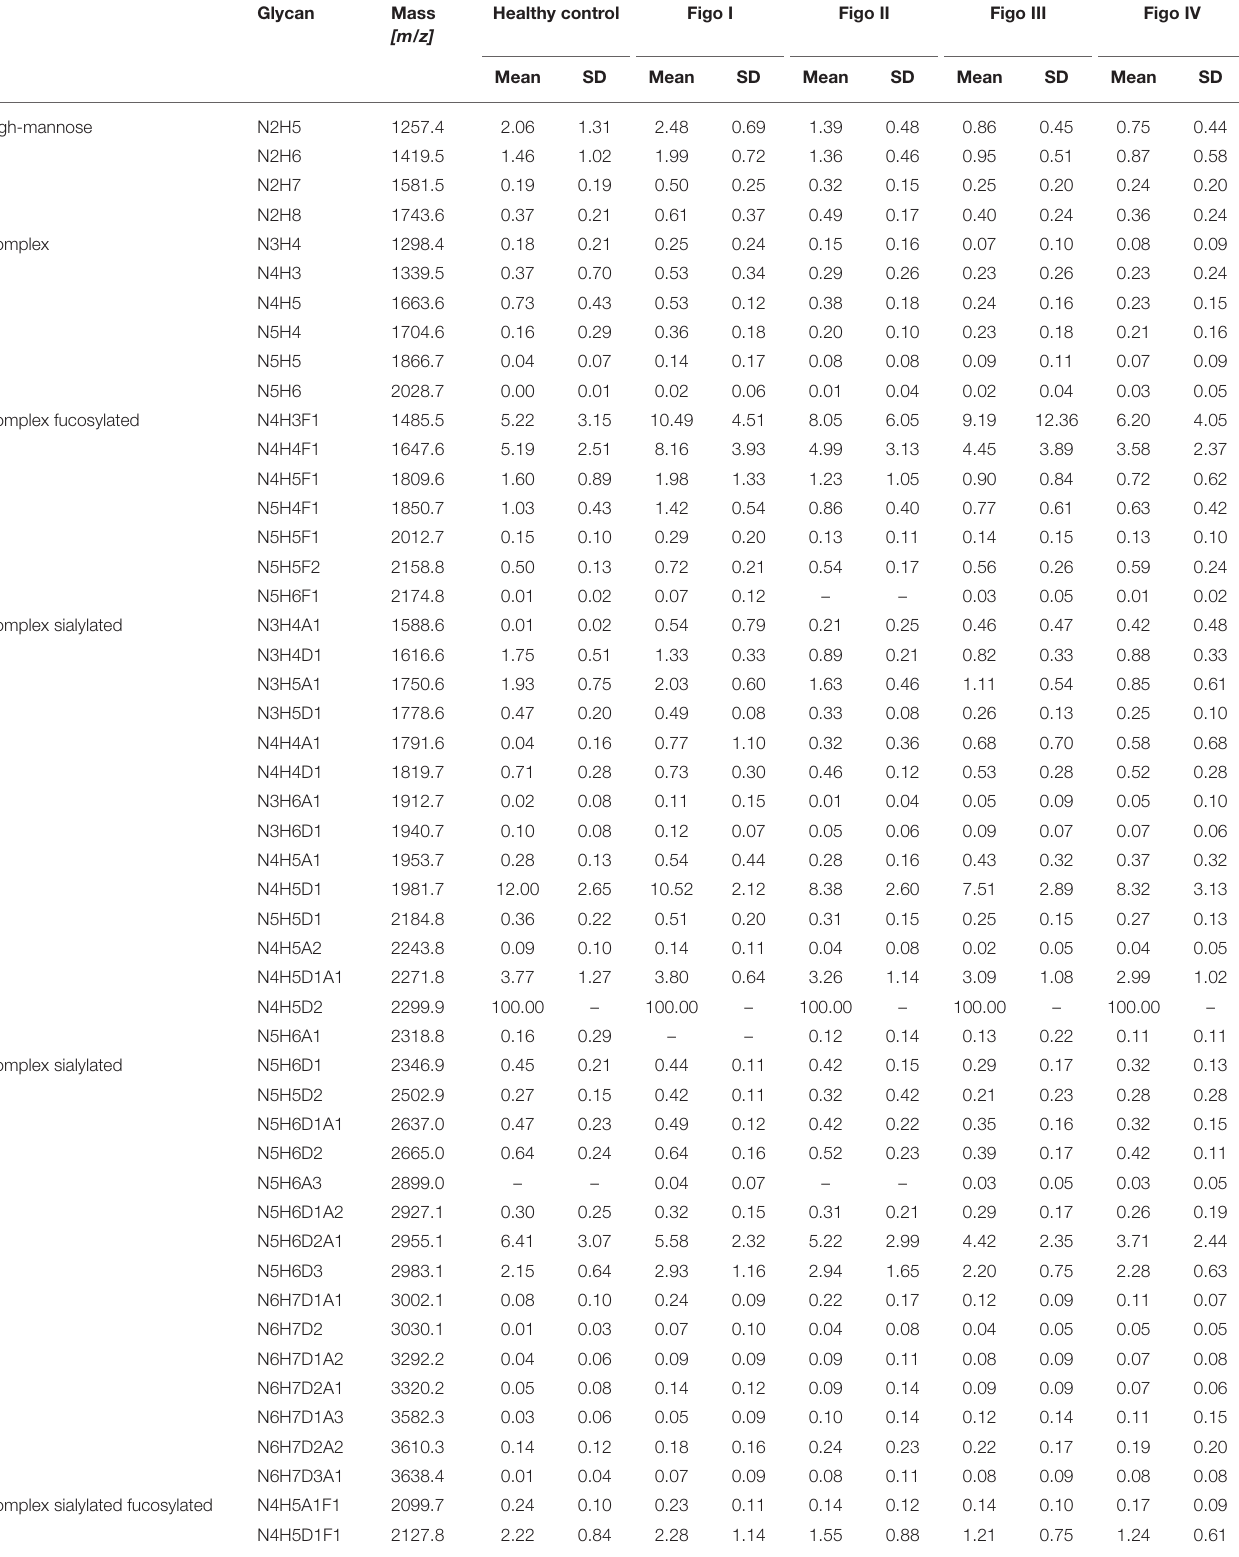
TABLE 2 | Mean relative intensities (normalized to the base peak intensity) and SD of all detected structures across ovarian cancer stages measured by